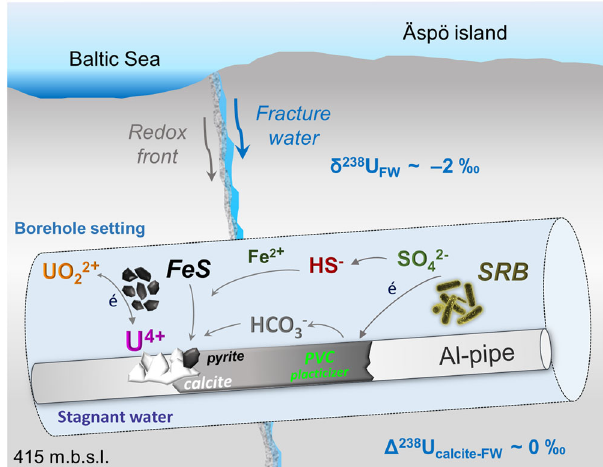
Fig. 5 A tentative model for U removal and δ 238 U during U fl ow in granite fracture network in the Äspö HRL. The degradation of PVC plasticizer is promoted by SRB resulting in the formation of bicarbonate and sul fi